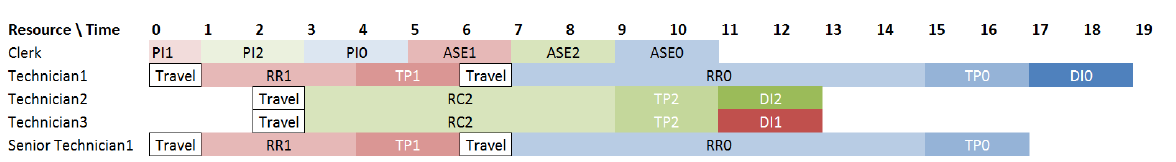
Figure 5. The optimal scheduling of 3 process instances of the process described in Figure 4